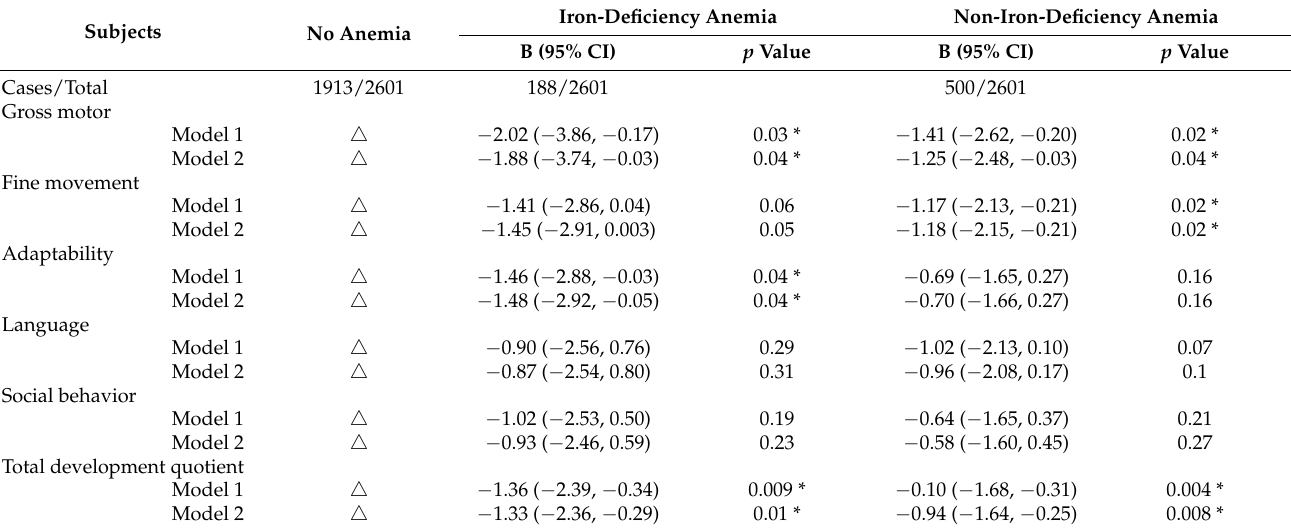
Table 4. Multiple linear regression analysis of effects of anemia types on neurobehavioral development of children aged 6–24